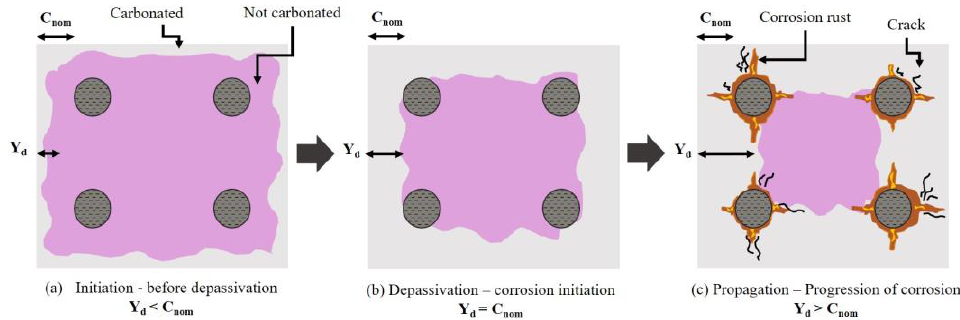
Figure 1. Reinforcement corrosion in RC structures due to CO 2 diffusion.